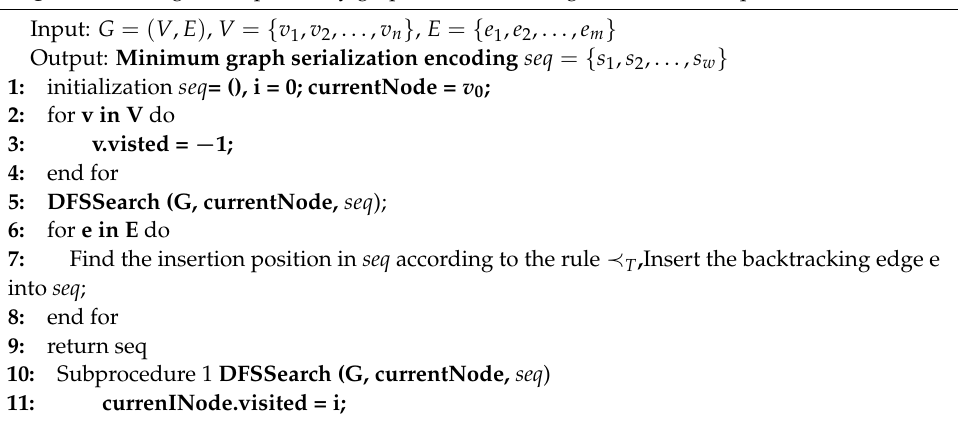
Algorithm 1 Program dependency graph serialization algorithm